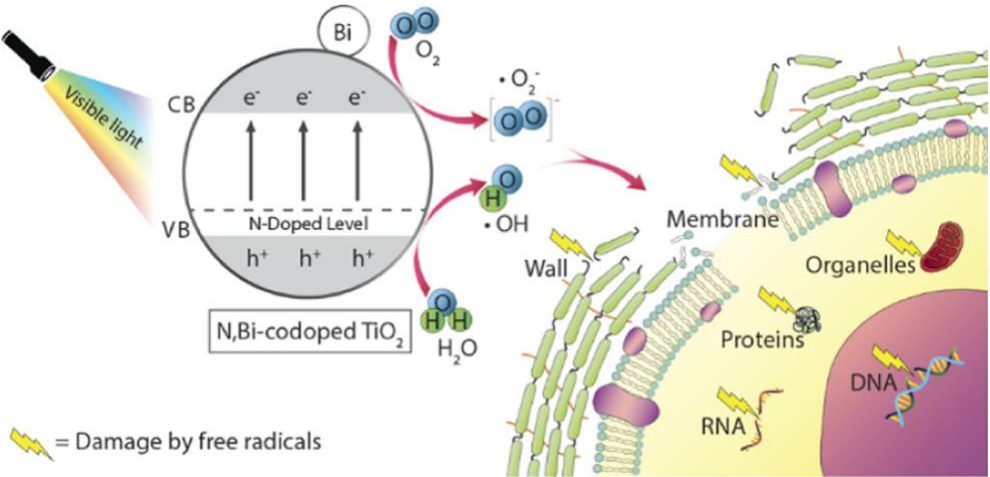
Figure 8. Schematic illustration of light-induced antibacterial mechanism of N, Bi-codoped TiO 2 photocatalysts. Bacterial DNA should locate in cytoplasm. Reproduced with permission from ref. [86]. Copyright © 2019, American Chemical Society.